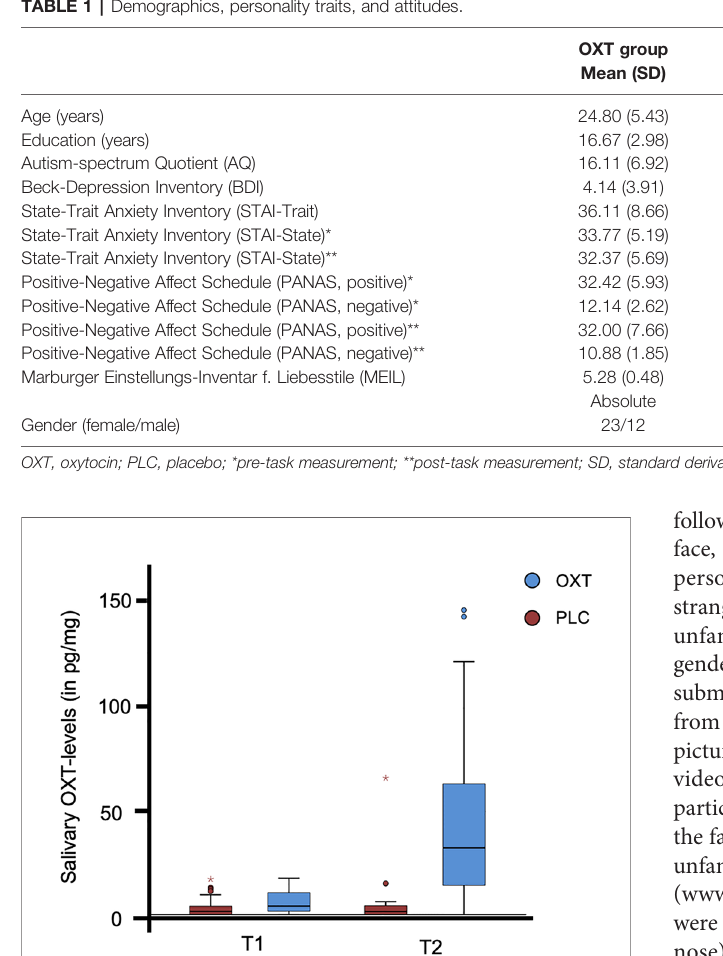
TABLE 1 | Demographics, personality traits, and attitudes.